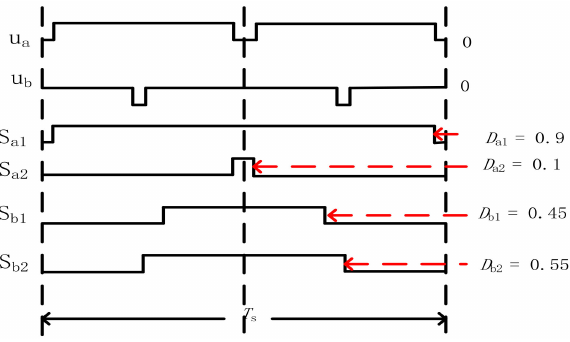
Figure 7. Modulation sequence.